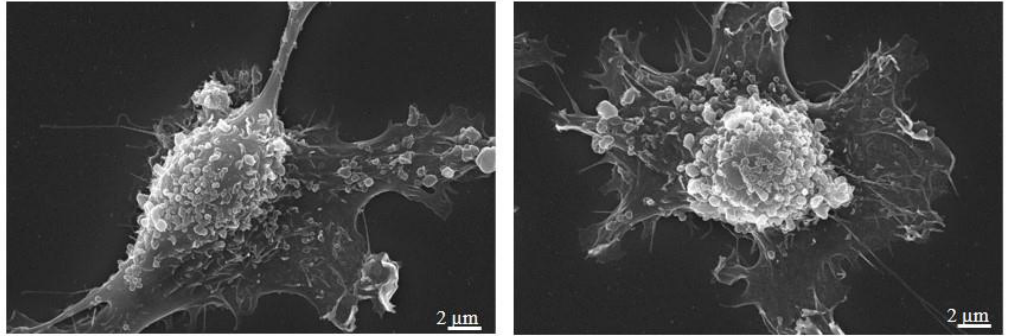
Figure 3. Scanning Electron Microscopy of MDA-MB-231 cells showing EVs release from cell surface. Magnification 10,000×; scale bar 2 µm (personal images).